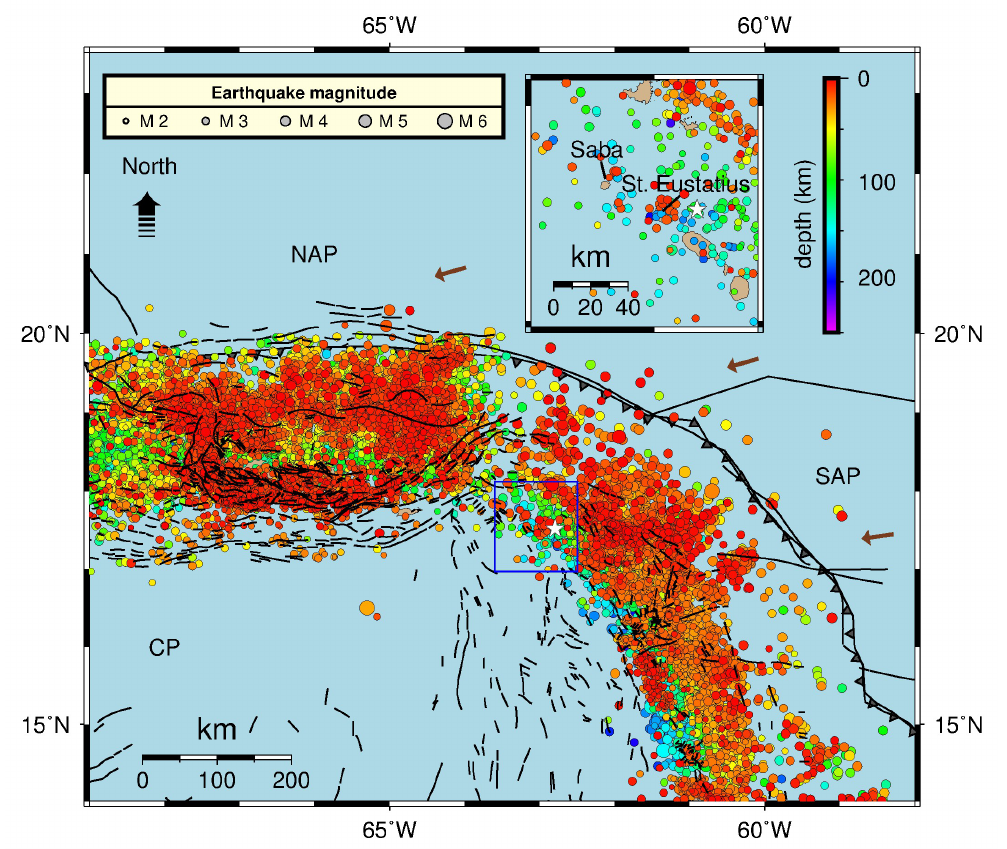
Figure 3. Epicentres and depths of earthquakes (M 2.0–6.1) in the region around Saba and St. Eustatius between 1 January 2010 and 15 March 2018 (data from ISC). Plate boundaries for the North American plate (NAP), South American plate (SAP) and the Caribbean plate (CP) are taken from Bird [16]. Tectonic faults [17] are indicated in black. The brown arrows represent the motion of about 20 mm per year of the NAP relative to the CP [18]. The blue rectangle on the map is enlarged on top. The white star indicates the magnitude 4.3 earthquake on 14 March 2017 at 18:35 UTC at a depth of 87 km (USGS) just east of St. Eustatius for which the waveform data are presented in Section